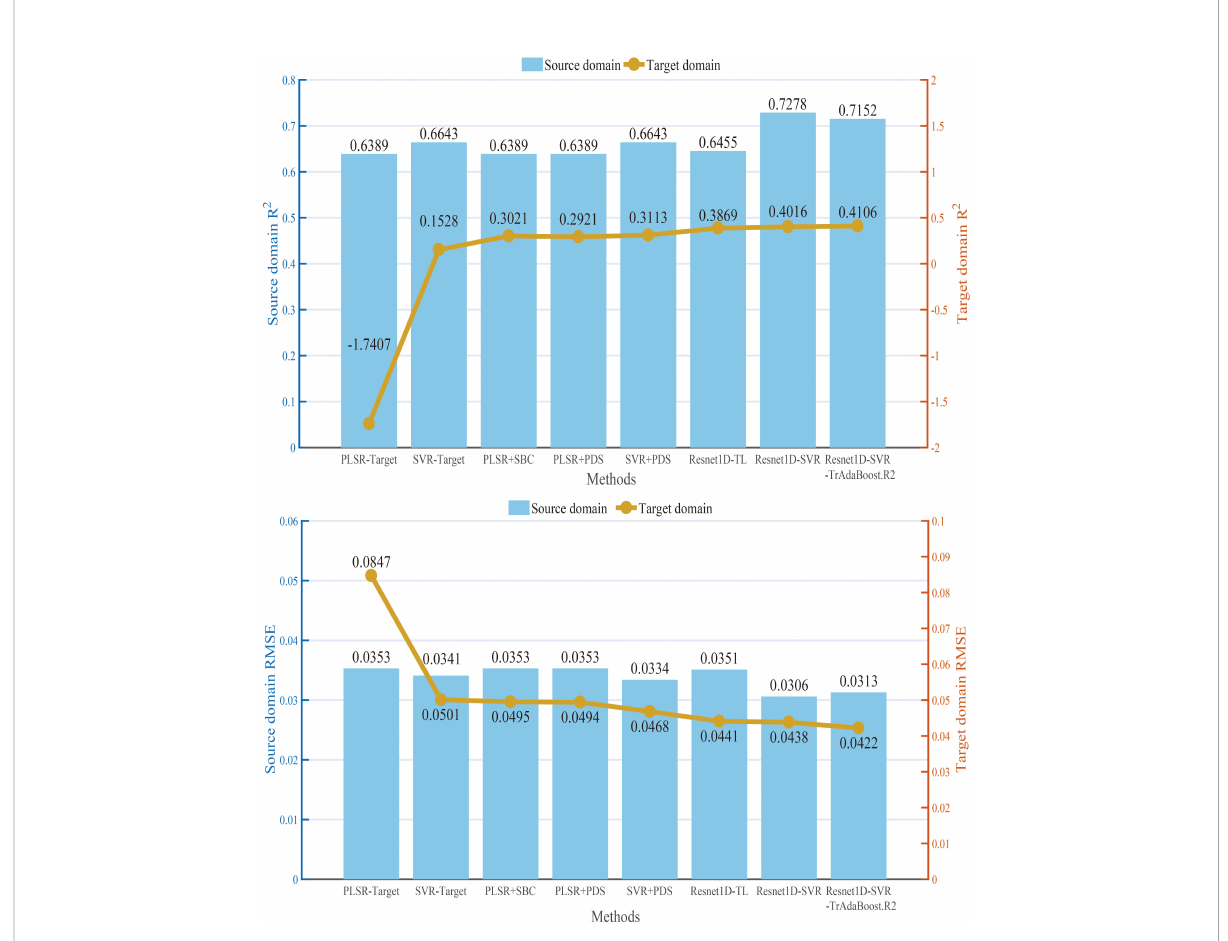
FIGURE 7 R 2 and RMSE values of different calibration transfer methods in source and target domains. RMSE, root mean square